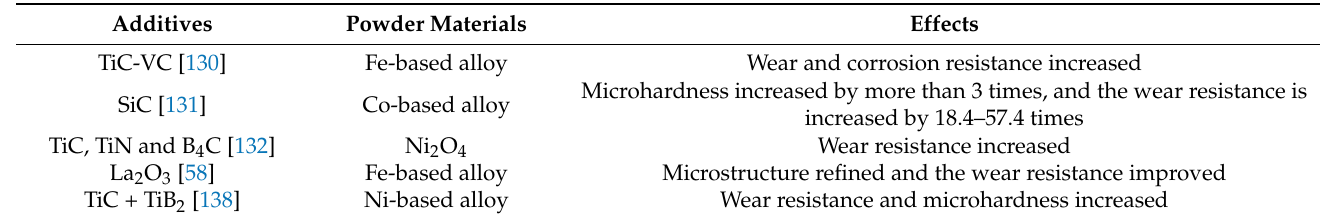
Table 3. Various additives and their enhancement